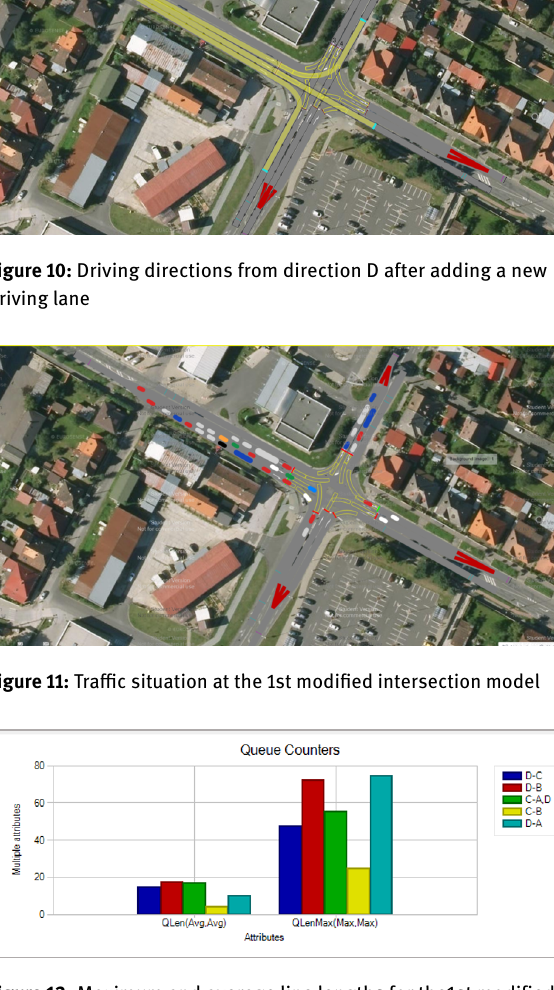
Figure 12: Maximum and average line lengths for the1st modified intersection model